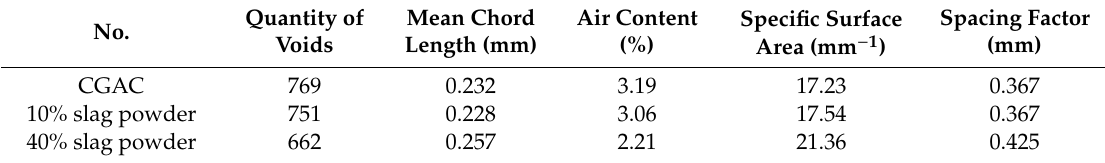
Table 8. Air-void characteristic parameters of CGAC with di ff erent cement substitution